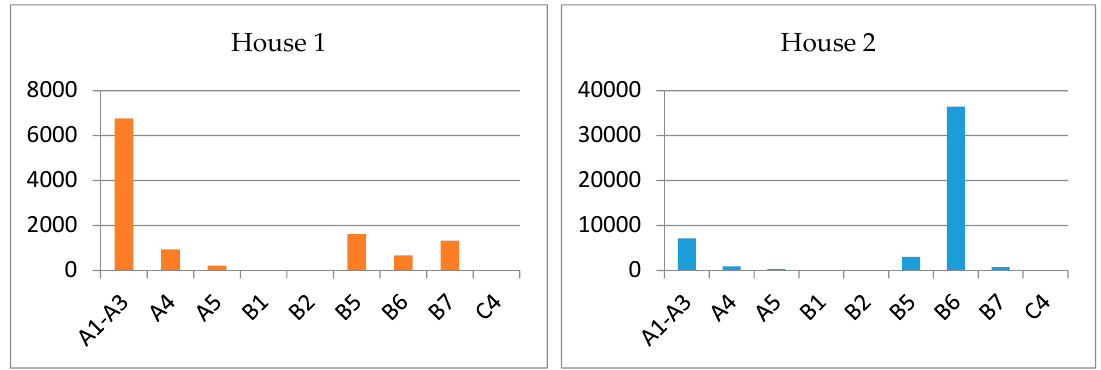
Figure 3. LCA module impacts of ADPF (MJ), A1–A3 Product Stage; A4 Transport of Equipment